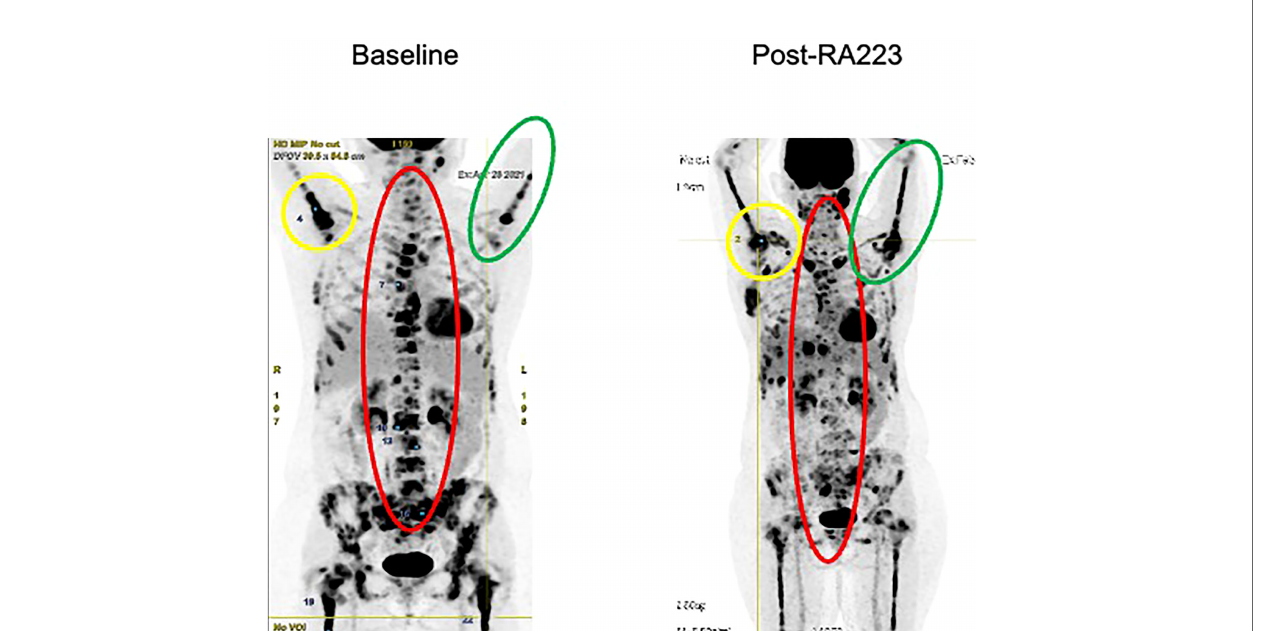
FIGURE 1 | FDG PET-Scan before and after radium-223 treatment. The images circled in red depict a decrease of FDG uptake in axial skeletal metastases, re fl ecting a response to treatment. The images circled in green illustrate medullary regeneration in humerus and femur after treatment by showing homogeneization of FDG uptake. The images circled in yellow illustrate a decrease of FDG uptake in the right humeral head. For example, the Maximum Standardized Uptake Value (SUVmax) decreased of 59.2% in the at the 10th dorsal vertebra (12.38 in pre- to 5.05 in post- radium-223) and of 63.6% in the sacrum (14.91 in pre- to 5.43 in post-radium-223). The SUVmax of the Aorta bloodpool was 2.76 in pre- and 2.25 in post-radium-223 (-18%). The SUVmax in normal liver (reference) was 2.14 in pre- and 2.20 in post-radium-223 (+2.8%).